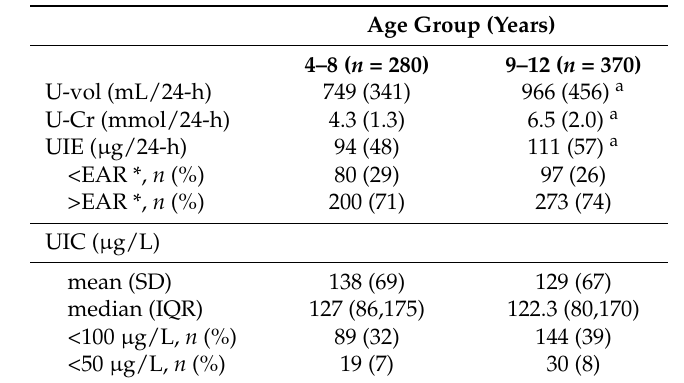
Table 2. Urinary parameters by age group ( n = 650).